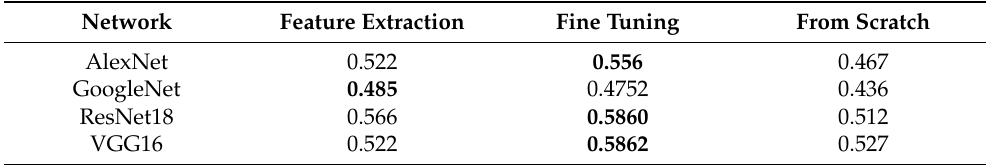
Table 1. Validation accuracy reached by each network for different training methods. Feature extraction freezes the weights in the convolutional layers. The best result for each network is remarked.